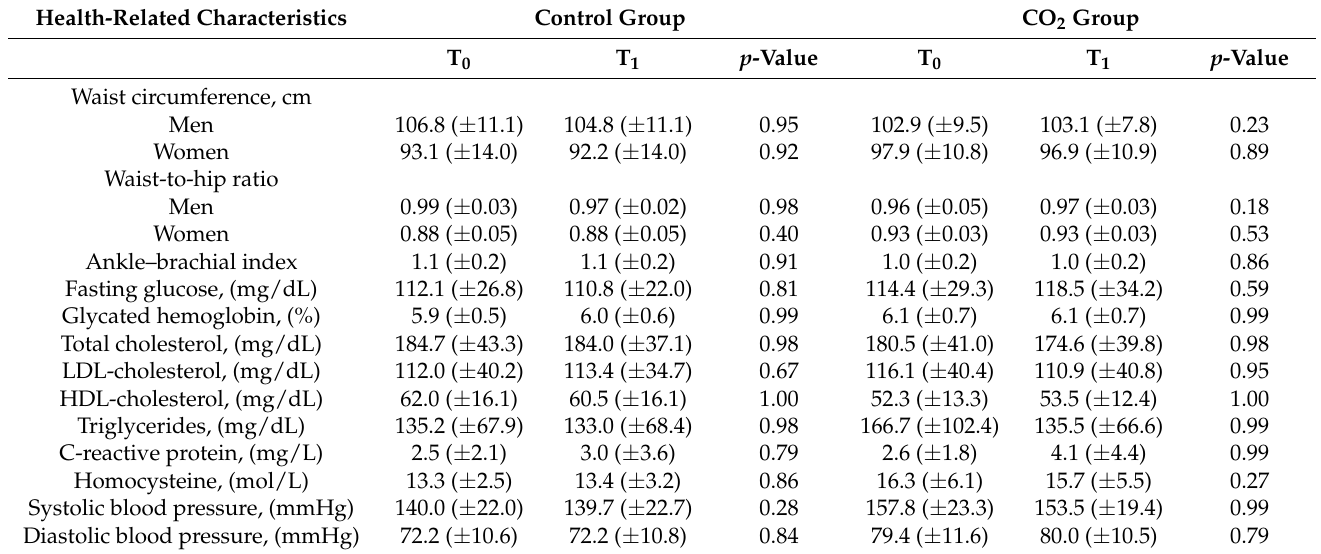
Table 2. Health-related